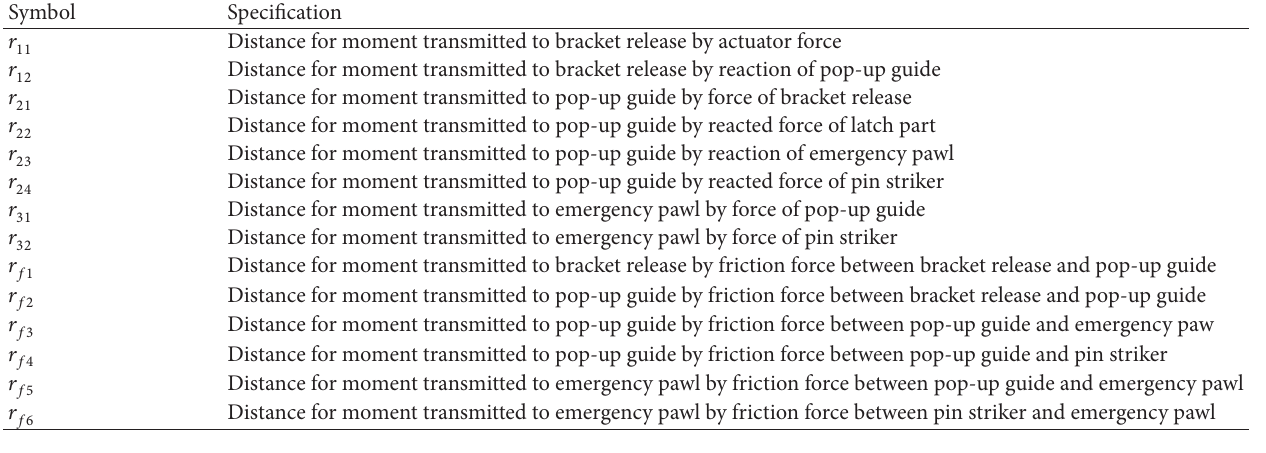
Table 2: Variables for equation distances.